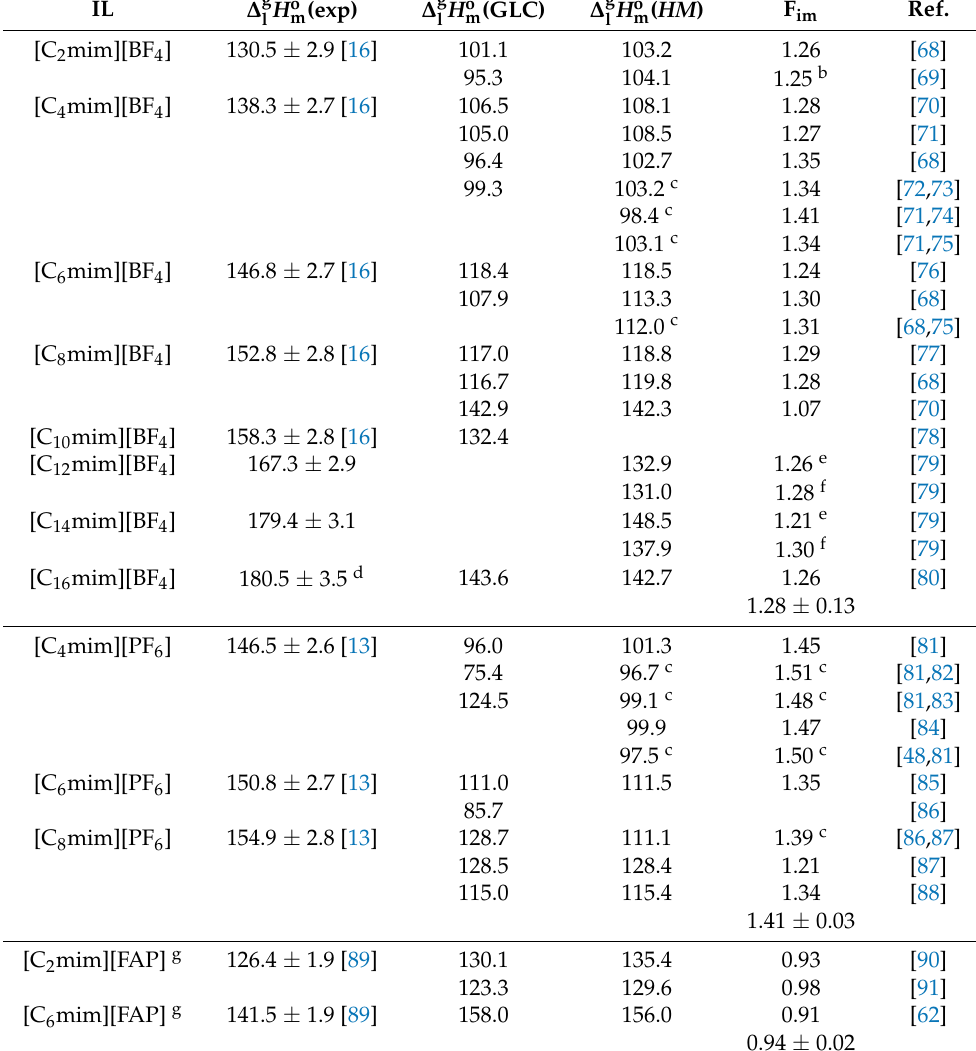
Table 4. [C n mim][Anion] series with fluorine-containing anions: comparison of ∆ g derived according to Equations (5) and (6) with experimental results from conventional methods a